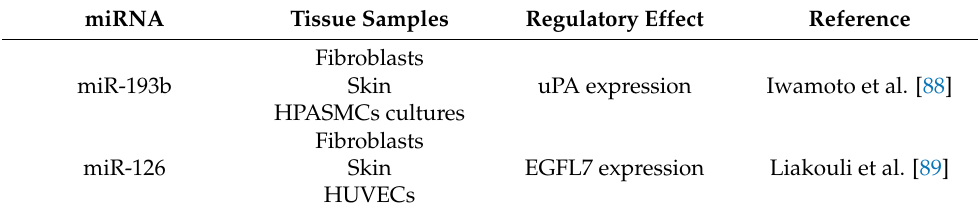
Table 4 represents a summary of the modulatory effects of miRNAs in SSc vasculopathy. Table 4. Microangiopathy and miRNAs. miRNA Tissue Samples Regulatory Effect Reference Fibroblasts miR-193b Skin HPASMCs cultures